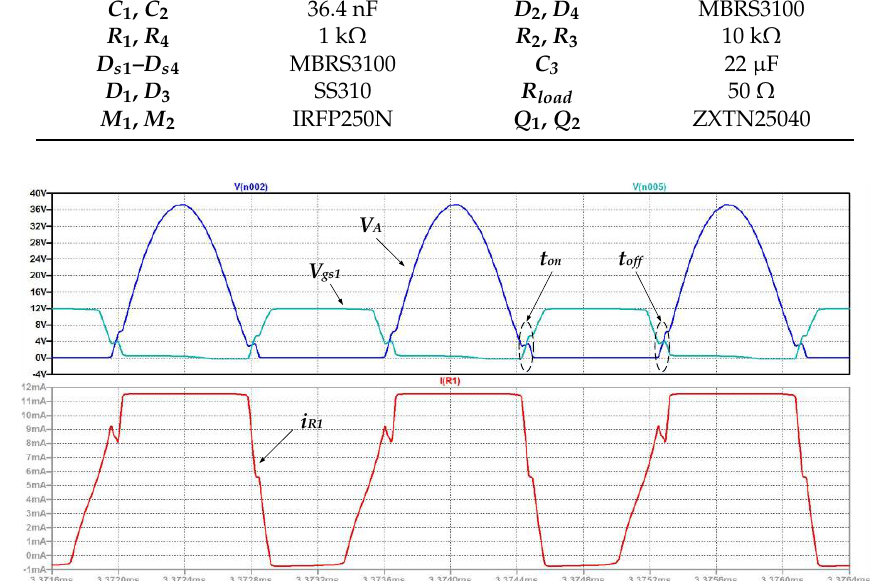
Figure 8. Voltage and current waveforms of the improved circuit simulation at V DC = 12 V.